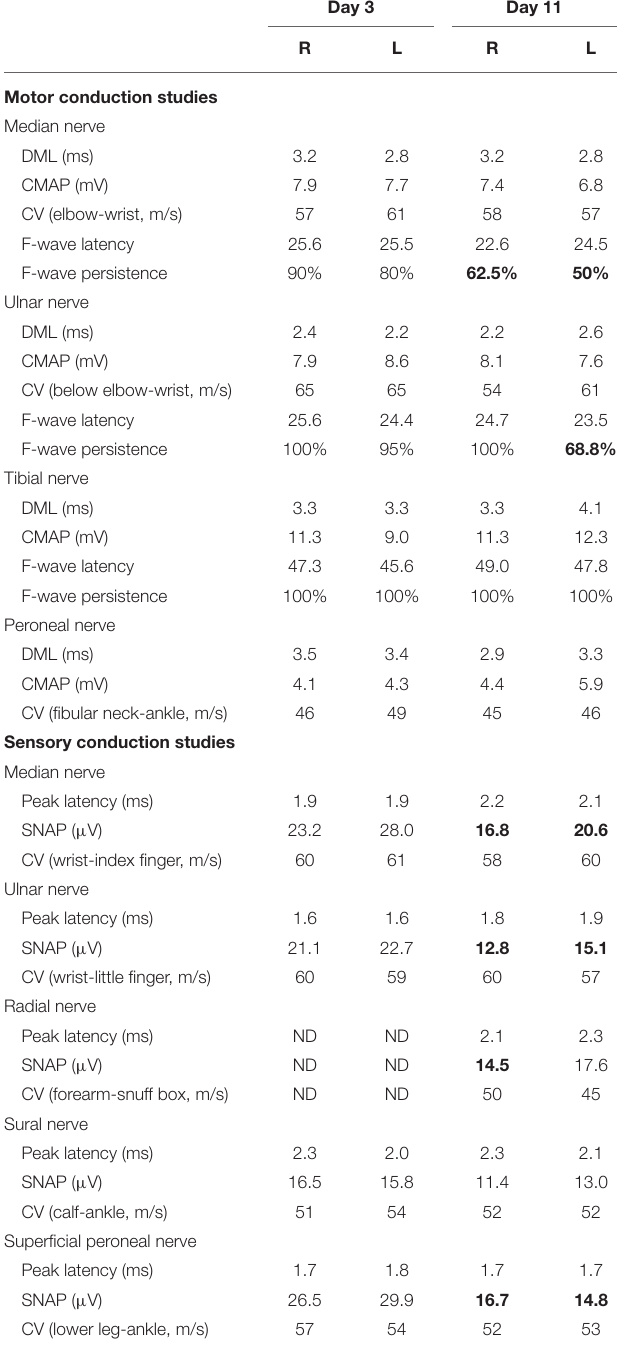
TABLE 1 | Motor and sensory nerve conduction studies of case